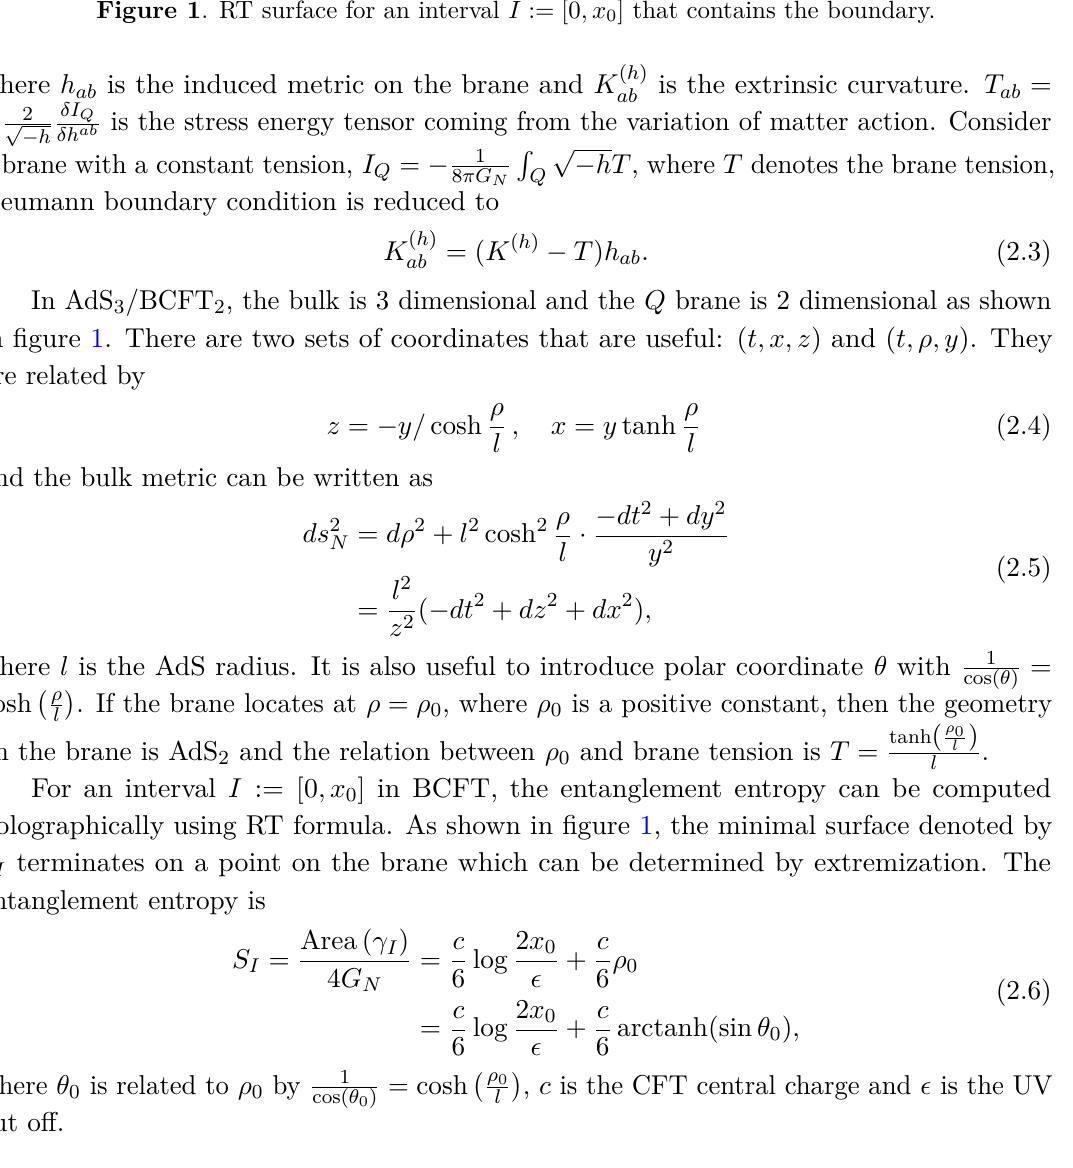
Figure 1 . RT surface for an interval I := [0 , x 0 ] that contains the